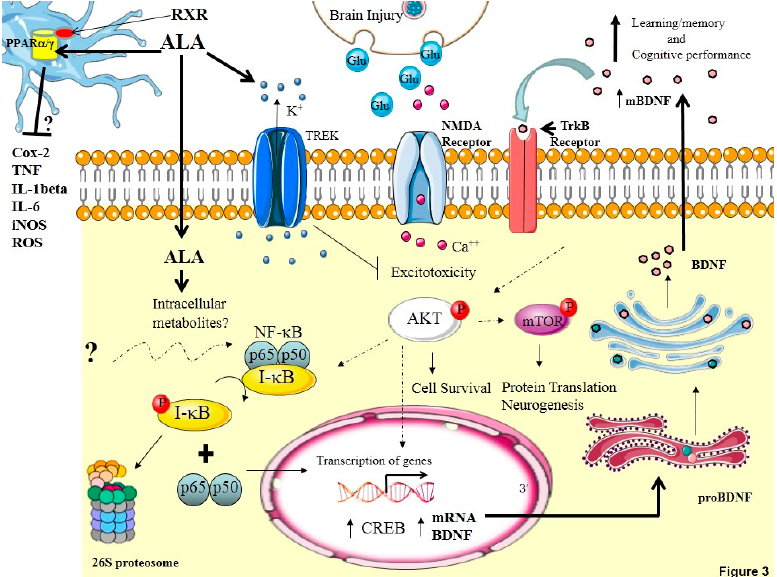
Figure 3. Overview of possible mechanisms involved in ALA-mediated neurorestoration. Injury to the brain results in the excessive release of glutamate (Glu) leading to the overactivation of NMDA receptors and neuronal cell death. Administration of ALA results in the formation of lipid rafts, an increase in activated nuclear factor kappaB (NF- κ B) levels and cyclic AMP response element binding protein (CREB) [216] and enhanced levels of BDNF mRNA and protein in the hippocampus. Release of mature BDNF into the extracellular milieu results in the rapid activation of TrkB receptors and NMDA receptors to promote neuronal survival and enhance neurotransmission [217]. Activation of TrkB leads to the downstream activation of Akt which in turn activates mTORC1 to increase neurogenesis, differentiation and an increase in the number of mature neurons. The increase in mature neurons can integrate into and enhance functional neuronal networks which in turn enhances cognitive and behavioral outcome. It is also possible that ALA binds to the peroxisome proliferator activated receptors gamma (PPAR γ ) and/or peroxisome proliferator activated receptors alpha (PPAR α ) along with the retinoic acid receptor (RXR) in the nuclei of microglia to reduce the release of pro-inflammatory mediators such as interleukin-1 beta (IL-1 β ), interleukin-6 (IL-6), the inducible form of nitric oxide (iNOS), tumor necrosis factor (TNF), cyclo-oxygenase-2 (COX-2) and reactive oxygen species (ROS) possibly by reducing the activity of NF- κ